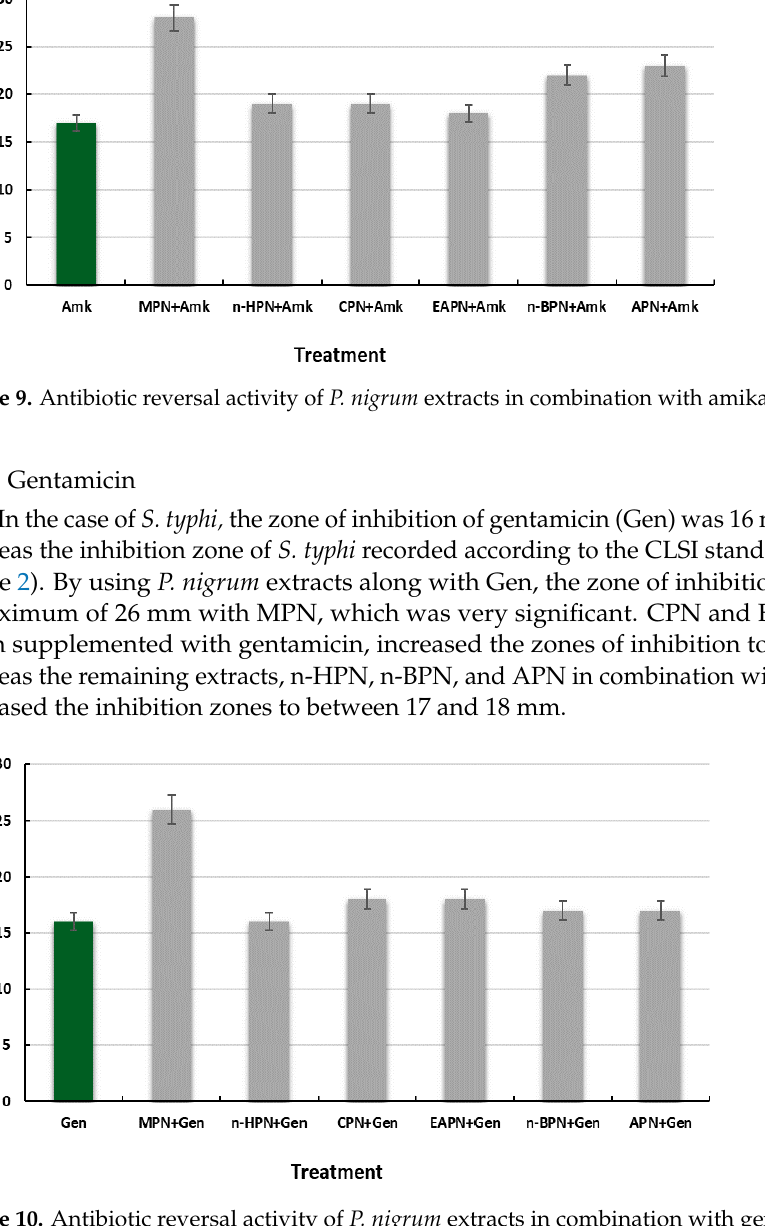
Figure 10. Antibiotic reversal activity of P. nigrum extracts in combination with gentamicin (10 μg) for S. typhi .